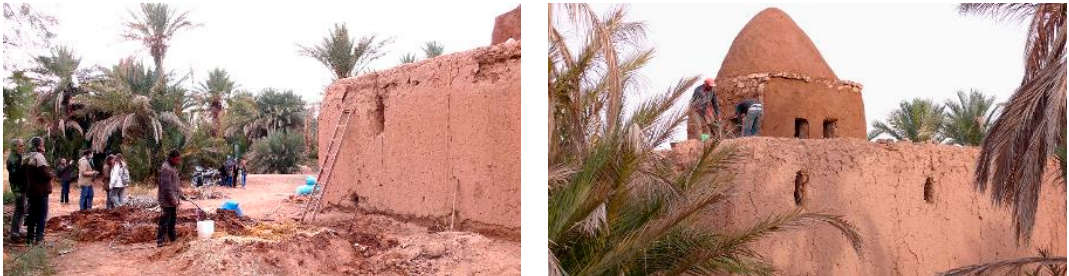
Figure 10. Restoration works of the marabout.